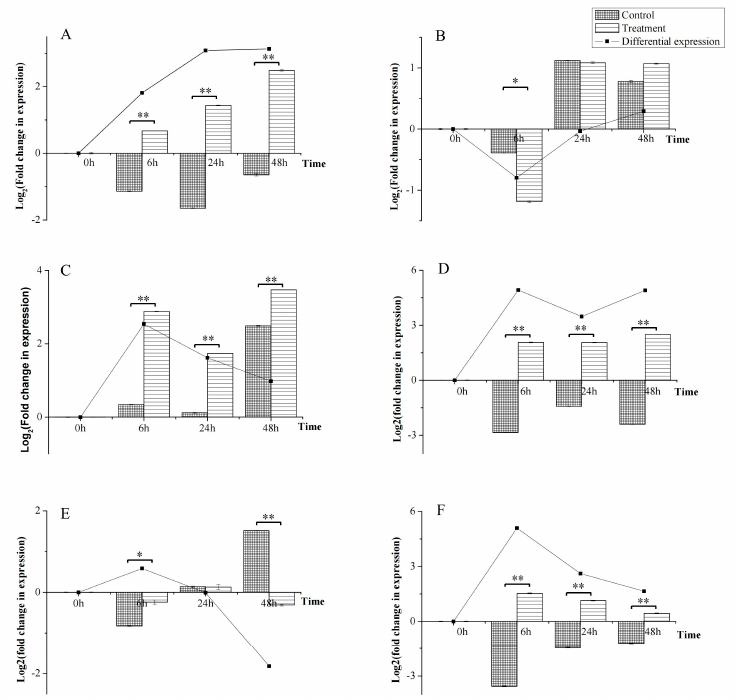
Figure 6. Transcription analysis of six ABC genes. Expression of ABC protein in Trichoderma asperellum cultured in MM medium (Control) or toxin-induced medium, MM with 10% fermentation filtrate of Alternaria alternata (Treatment). Differential expression = Treatment − Control. Error bars represent standard deviation. ( A ): ABC01 ; ( B ): ABC02 ; ( C ): ABC04 ; ( D ): ABC05 ; ( E ): ABC30 ; ( F ): ABC31 (* p < 0.05, ** p < 0.01, n =